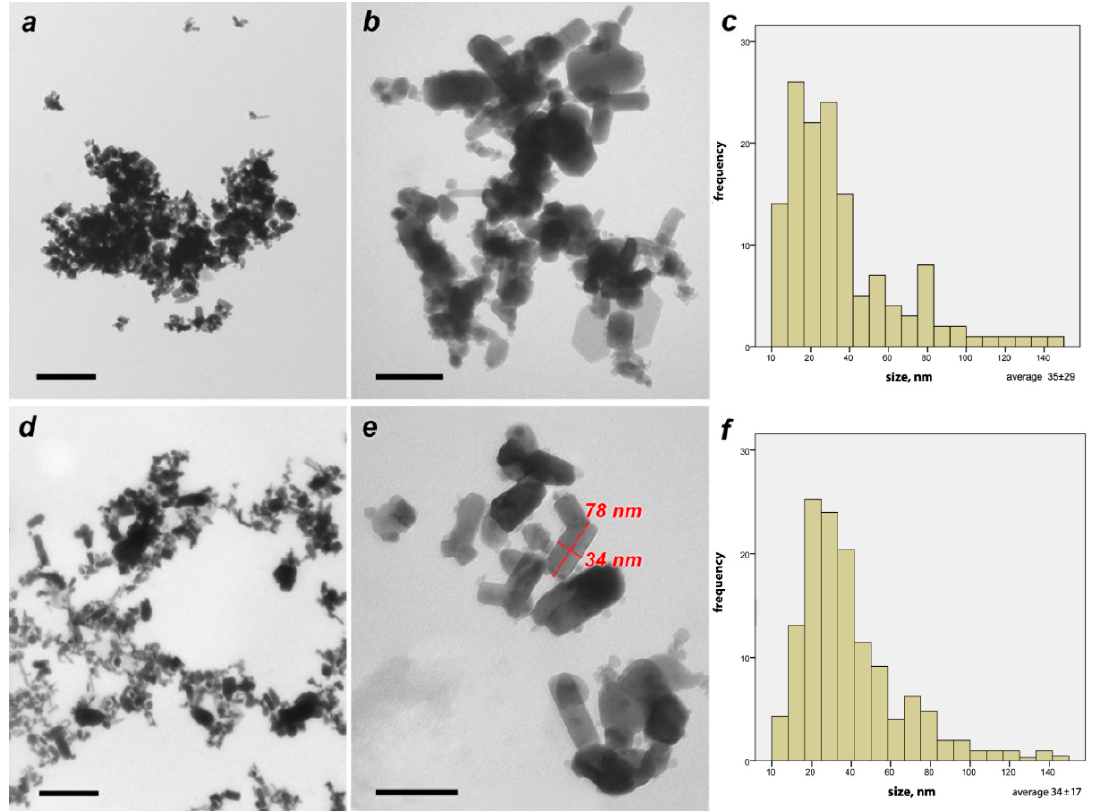
Figure 1. Zinc oxide nanoparticles: TEM images indicate particle size ( a , b ) powder form, ( d , e ) 300 mg/L, and ( c , f ) show particle size distribution and size distribution frequency of powder and 300 mg/L ZnO NP, respectively. Scale bar: ( a , d )—400 nm, ( b , e )—100 nm. The 2 θ values corresponding to 100, 002, 101, 102, 110, 103, 112 and 201 reflections